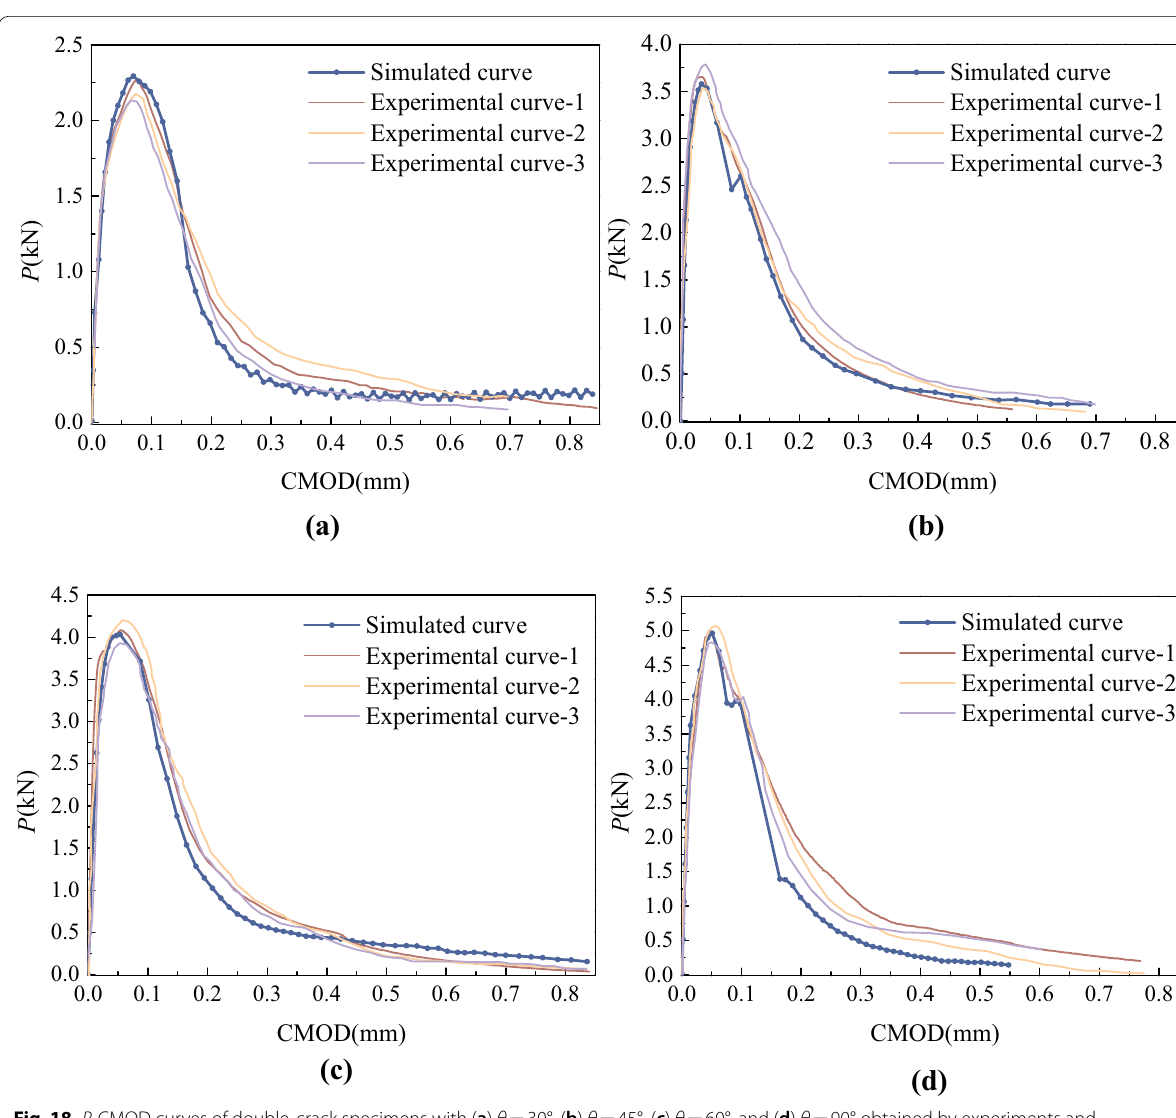
30°, ( b ) θ 45°, ( c ) θ 60°, and ( d ) θ 90° obtained by experiments and = = = =